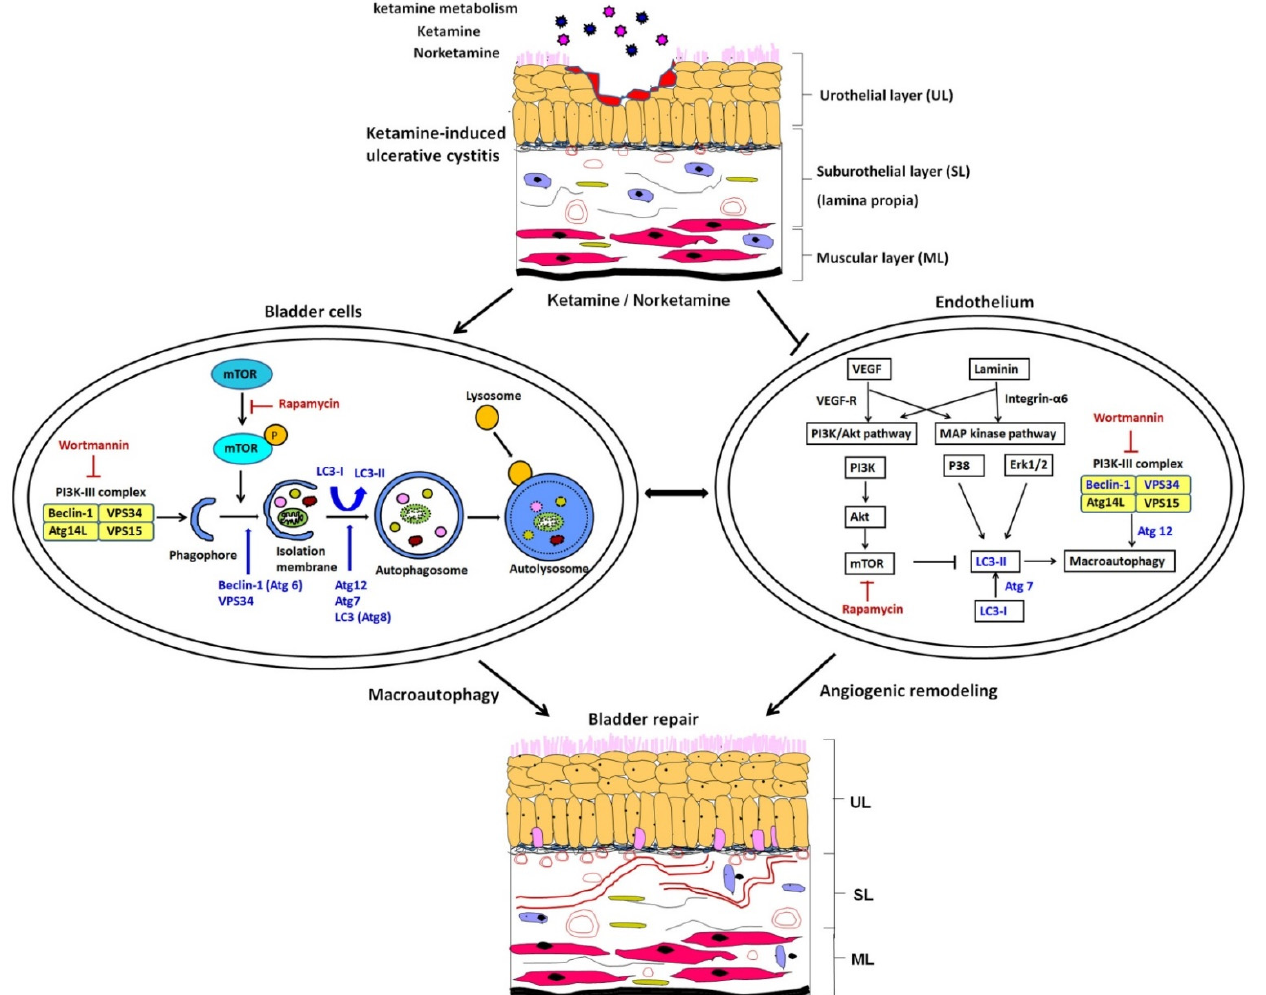
Figure 9. Representative image for the anti-angiogenesis potential of autophagy. The proposed potential mechanism of anti-angiogenesis was induced by ketamine and its metabolite through PI3K/Akt/mTOR pathway , leading to contribution to the pathogenesis of KIC. Our observations implied that treatment with ketamine significantly resulted in bladder overactivity, enhanced interstitial fibrosis, impaired endothelium, inhibited angiogenesis, and elevated the phosphorylation of Akt. However, these changes were ameliorated in the ketamine+rapamycin group. The application of rapamycin caused an inhibitory effect on vascular formation, removed ketamine metabolites, decreased the inflammation, and ameliorated bladder hyperactivity, leading to improving bladder function in KIC, while wortmannin improved bladder angiogenesis by increasing capillary density and VEGF expression, to reverse anti-angiogenic effect to repair KIC.